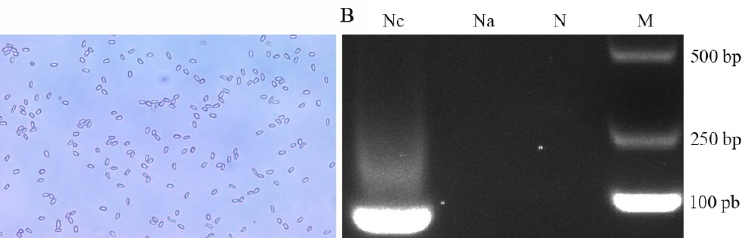
Figure 1. Microscopic detection and PCR validation of N. ceranae spores. ( A ) Microscopic detection (400 times amplification). ( B ) AGE for PCR amplified fragments, Lane Nc: Specific primers for N. ceranae , Lane